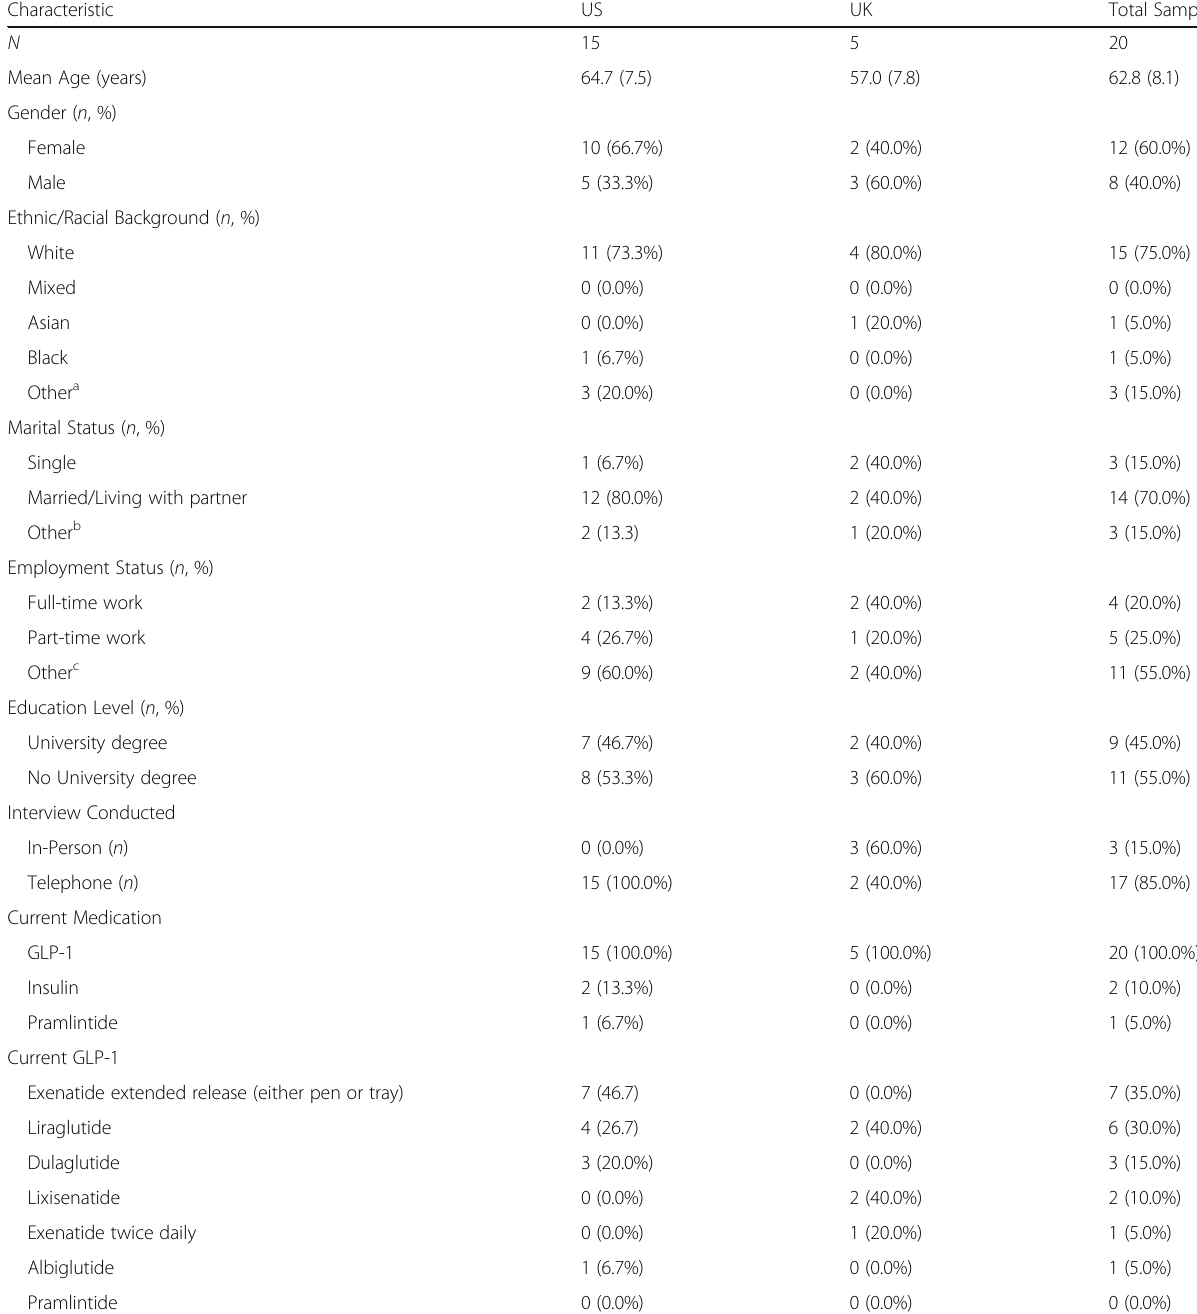
Table 4 Participant Characteristics (Cognitive Interviews)